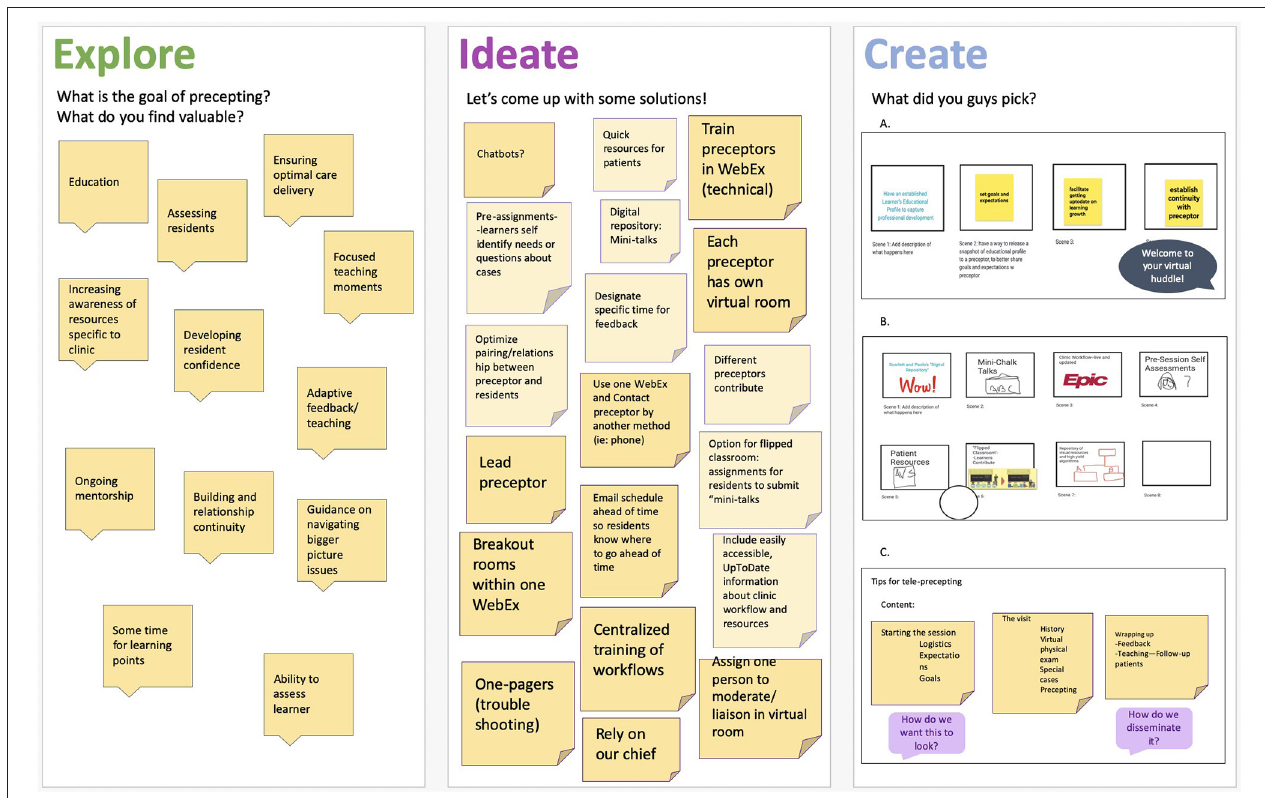
FIGURE 3 | Content and prototypes from the combined Design Thinking